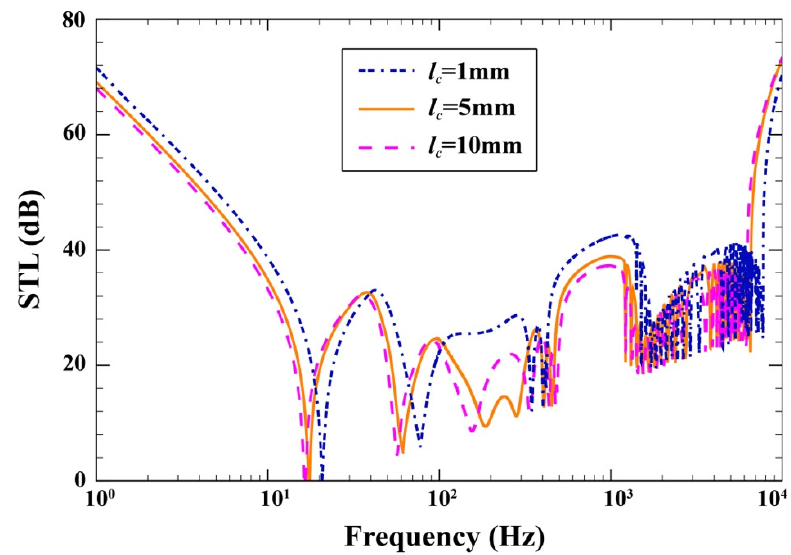
Figure 11. Effect of the hexagonal cell length on the changes of STL.